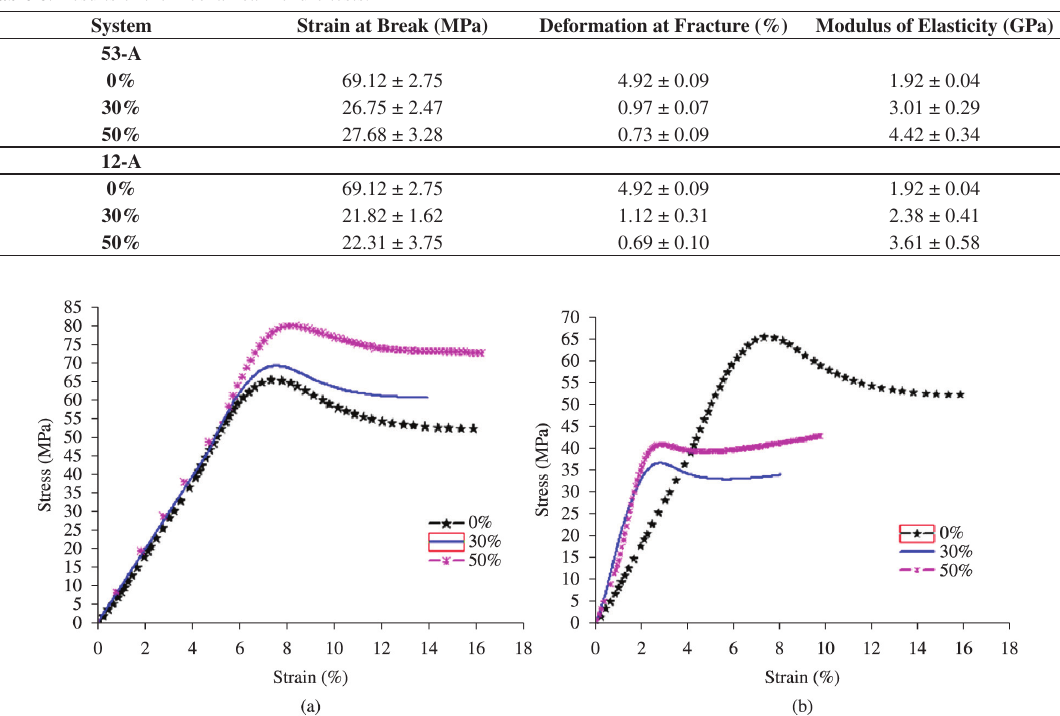
Figure 6. Tension-deformation curves illustrating the behavior under compression of polymeric systems for: a) epoxy resin and 53-A, and b) epoxy resin and